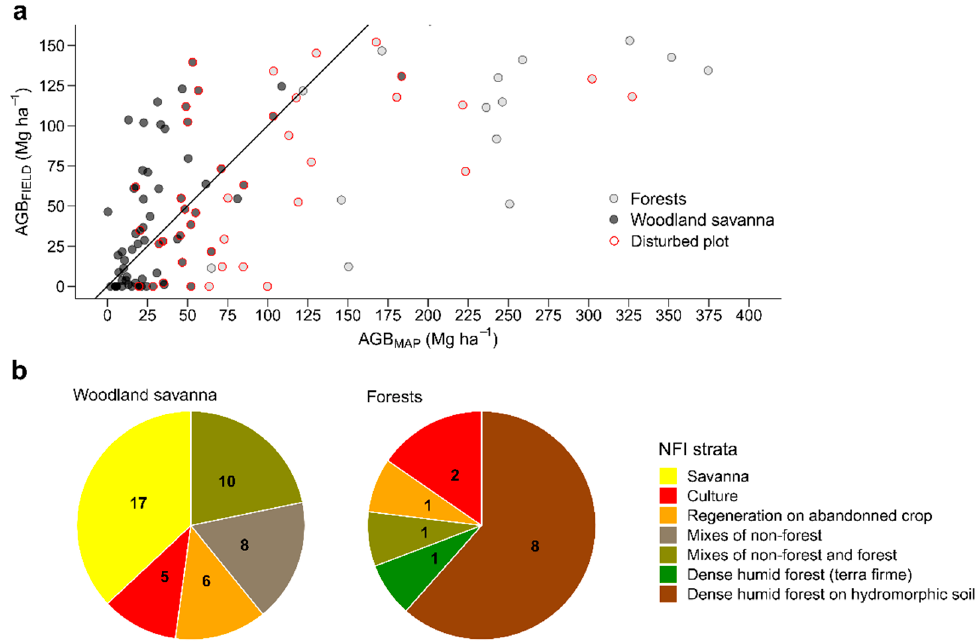
Figure 5. ( a ) Relationship between sample plots’ aboveground biomass derived from inventory data ( AGB FIELD ) and from the biomass map ( AGB MAP ) in the early AGB range (i.e., 0–150 Mg ha − 1 of AGB FIELD ). ( b ) Pie charts showing the proportion of landcover classes from the NFI landcover classi- fication found among plots belonging to the woodland savanna or to a forest class in the landcover map. Black numbers represent the number of plots by